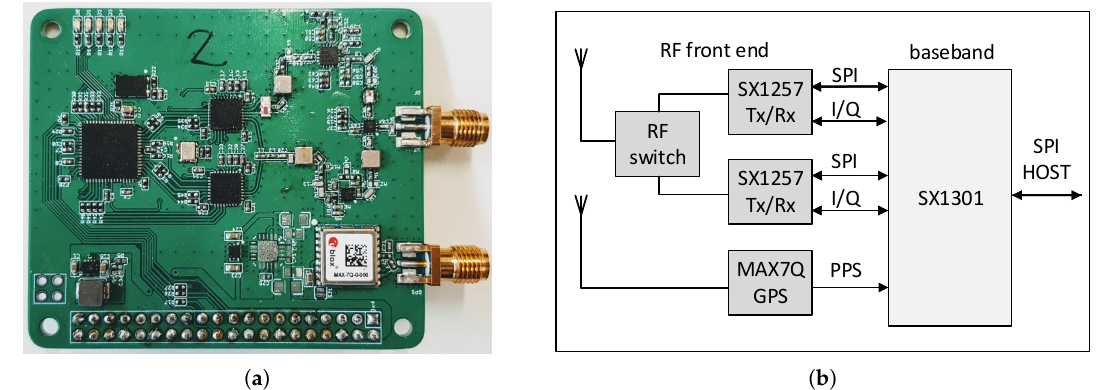
Figure 8. LoRaWAN concentrator (SX1301 + 2x SX1257 + GPS). ( a ) Concentrator board. ( b ) Block diagram of a concentrator [35].